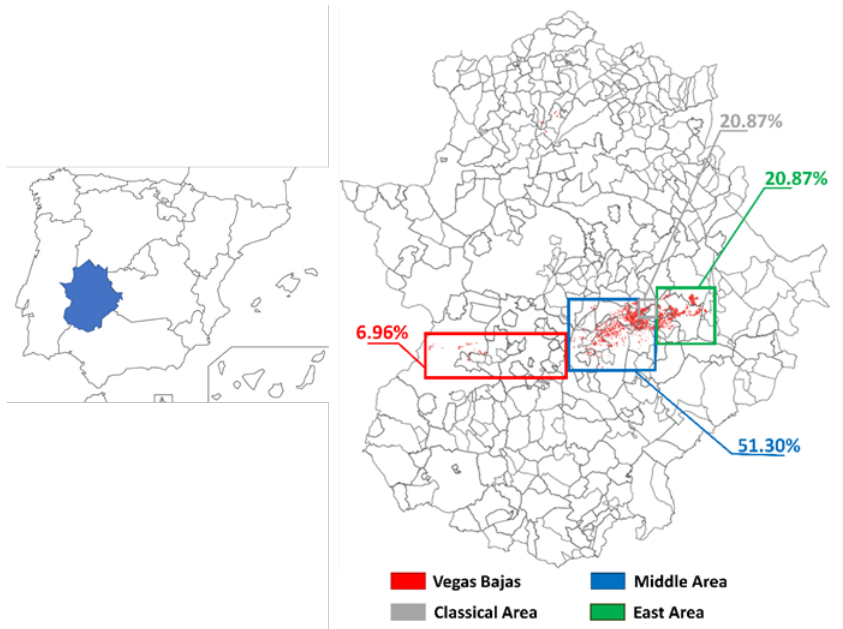
Figure 1. Distribution (%) of Echinochloa spp. populations sampled in the different areas of Extre-